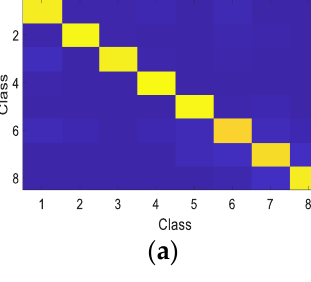
Figure 9. The confusion matrices of: ( a ) GCA-CNN; ( b ) GHFM-CNN; and the ( c ) OI-CNN on the synthetic SAR image.